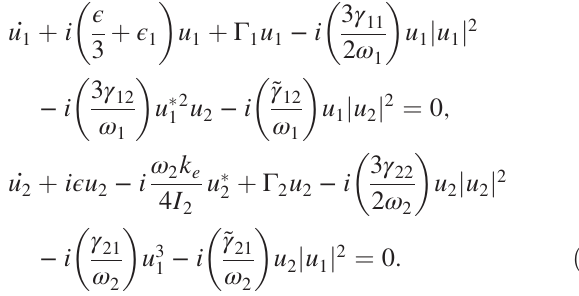
FIG. 7. (a) The parameter space of the drive frequency detune ϵ and the frequency mismatch ϵ 1 of the two modes for a pump amplitude of 6 mV. In the red regions, period-tripled oscillations can be excited in mode 1. The zero-amplitude state and the three period-tripled states are stable. In the white regions, only the zero- amplitude state is stable. (b) The pump amplitude is increased to 9 mV. In the light red region, there are two sets of stable period- tripled states in mode 1, together with the stable zero-amplitude state. The horizontal black dashed lines mark ϵ 1 ¼ − 16 . 4 Hz for the measurements in Figs. 2 and